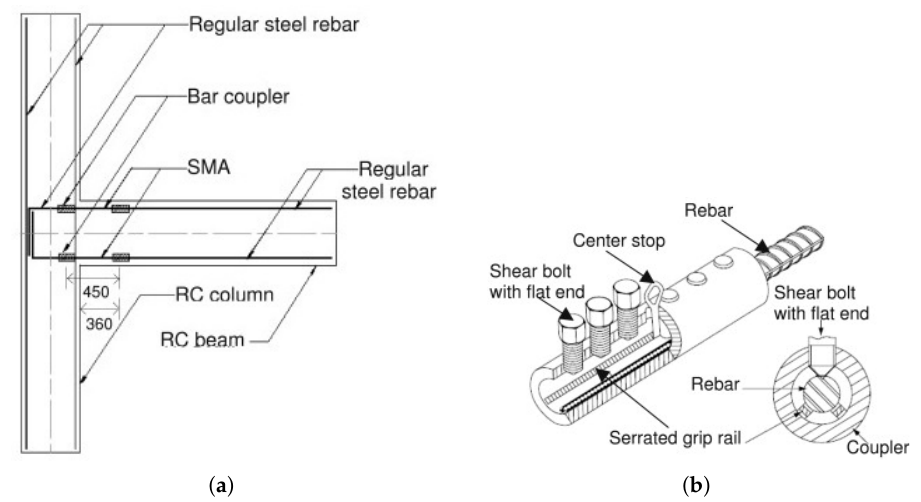
Figure 12. ( a ) Reinforcement details of specimen; ( b ) Splice details of specimen [65].